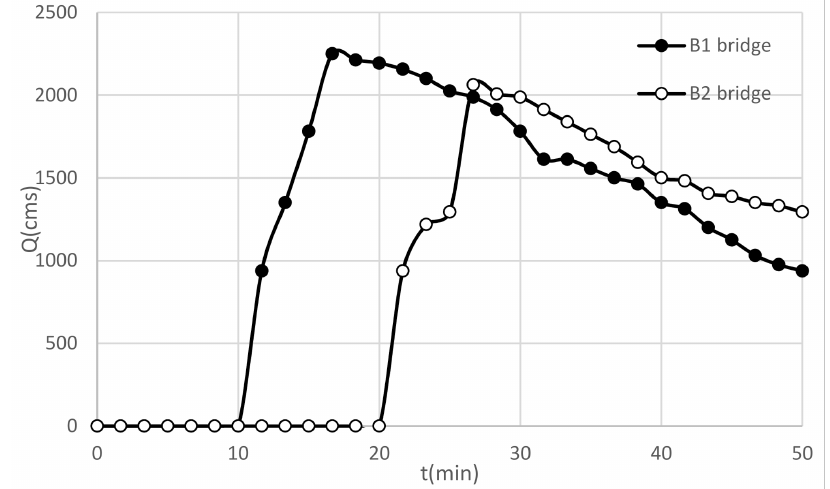
Figure 19. Flood flow hydrographs at bridges B1 and B2.